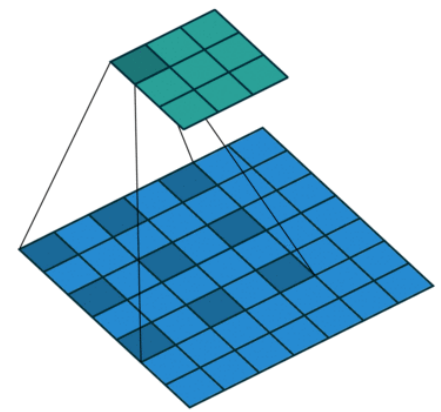
Figure 7. The DeepLabV3+ model.